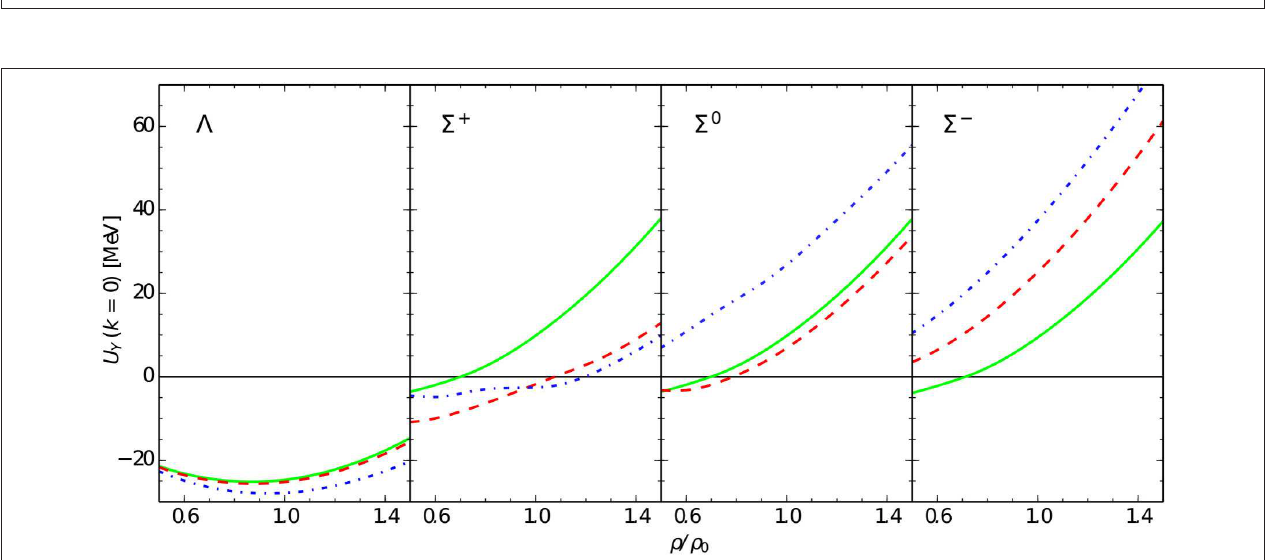
0 with different compositions of the nuclear matter, calculated in χ EFT at NLO with = 0.5 ρ , ρ p 0.25 ρ , and ρ p 0, = = =